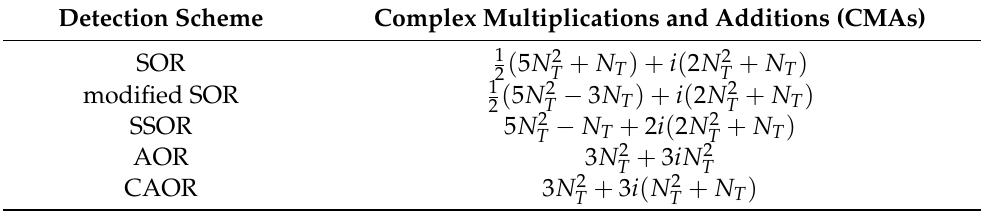
Table 6. Computational complexity of different detection schemes.